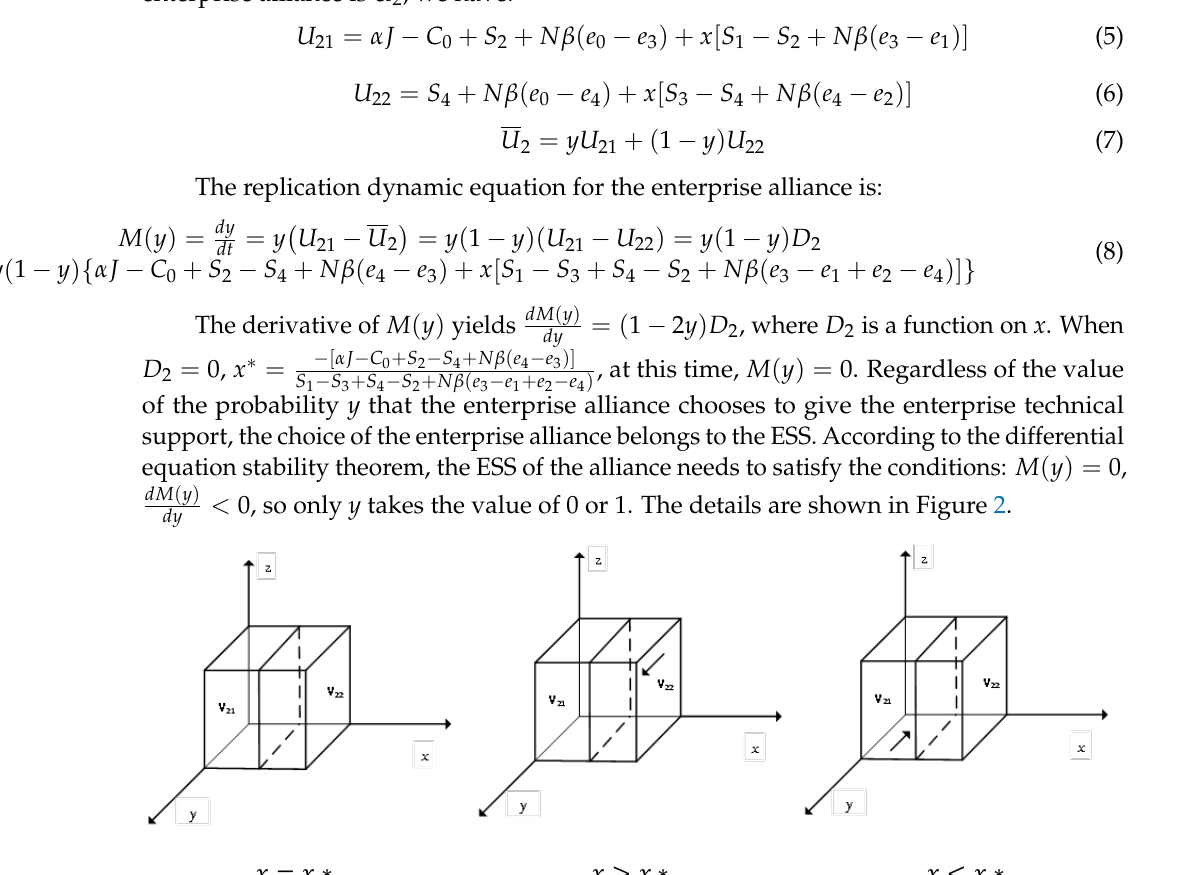
Figure 1. Evolutionary phase diagram of enterprise stabilization strategies.